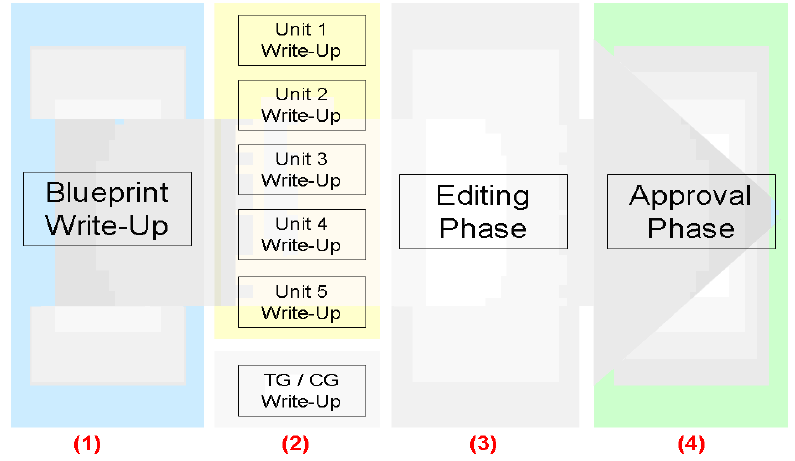
Figure 2: The four main phases of the course development